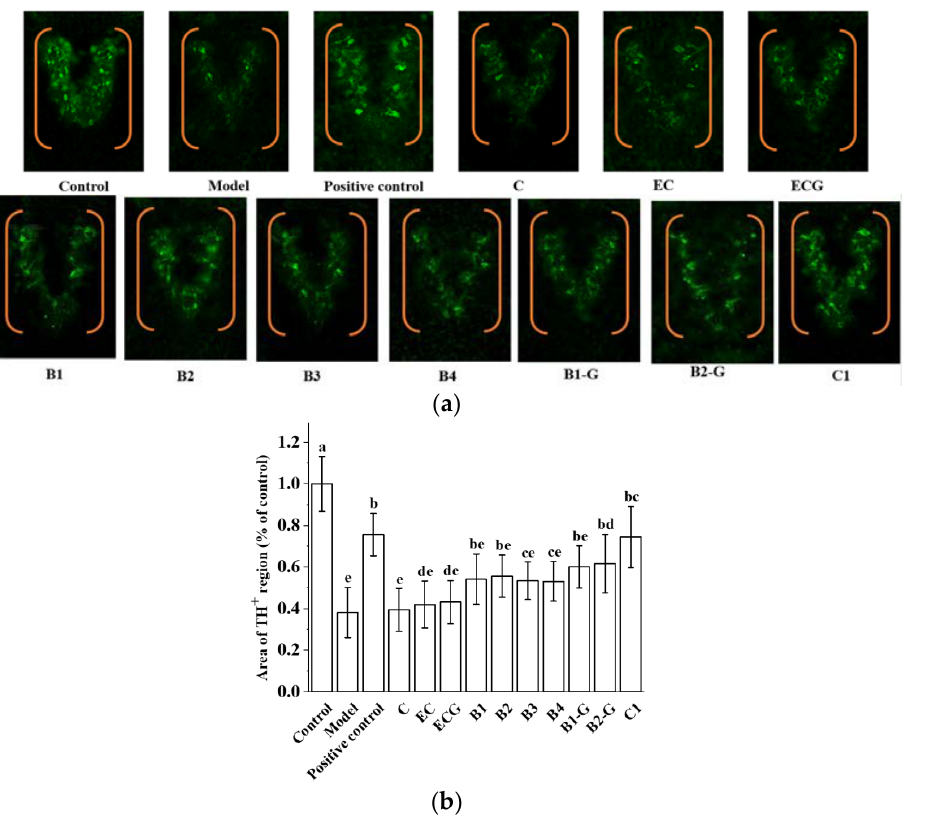
Figure 8. Effects of different structural procyanidins on dopaminergic neuron injury in the zebrafish PD model. ( a ) Representative pictures of the dopaminergic neurons in the brains of zebrafish. ( b ) Quantitative analysis of the tyrosine hydroxylase (TH) density. Control, Blank control group;